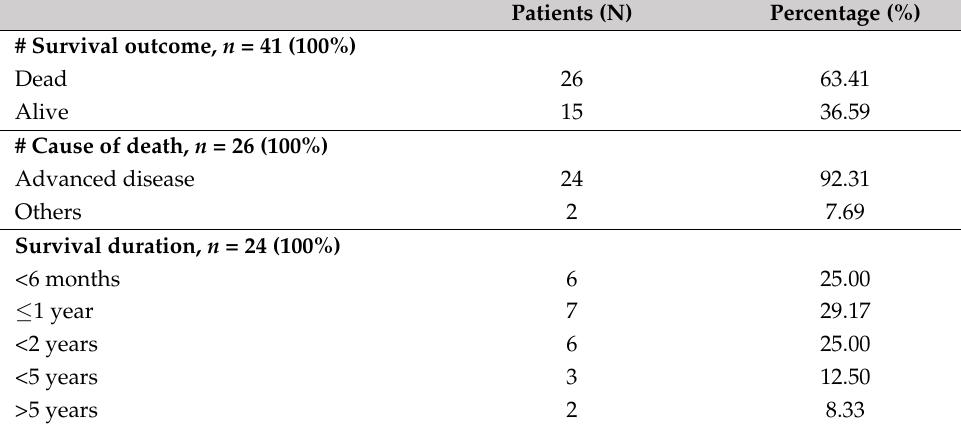
Table 7. Survival outcome of sarcoma patients.